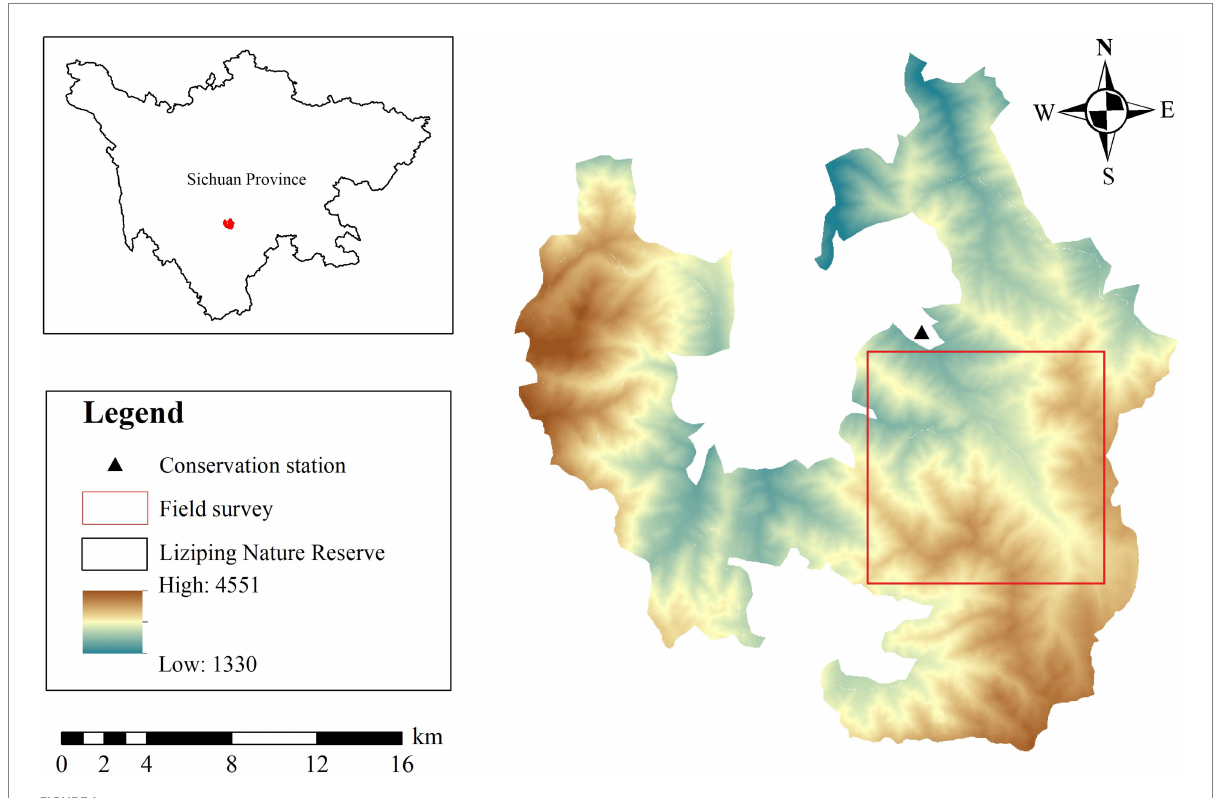
FIGURE 1 Study area in Liziping National Nature Reserve,